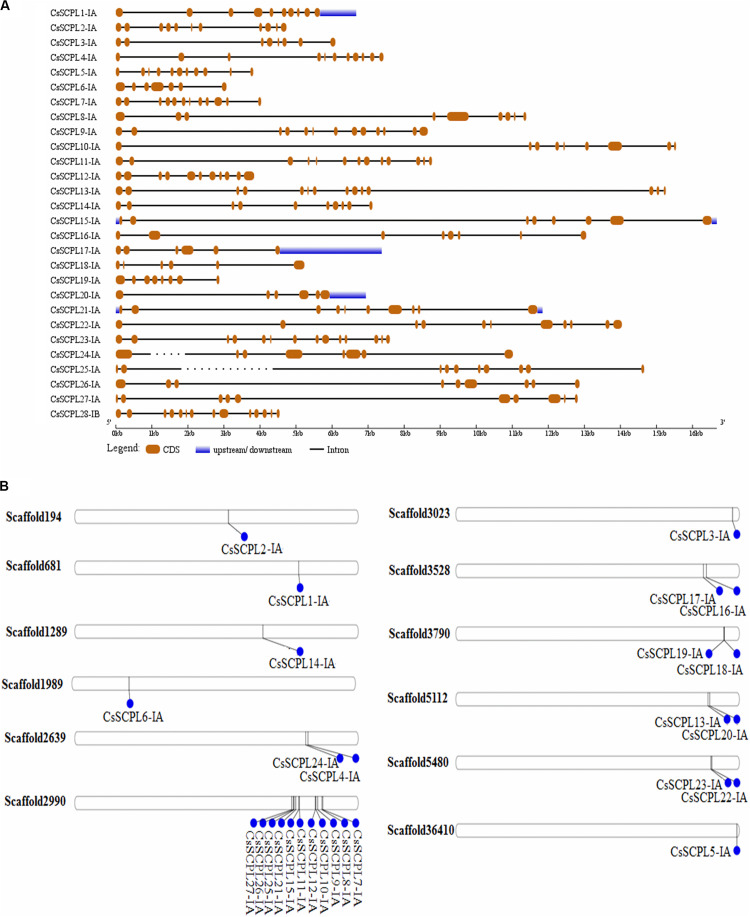
Gene architecture of tea CsSCPL genes. (A) The gene structures of CsSCPLI were plotted using red boxes representing exons, black lines representing introns, and blue boxes indicating UTR sequences. The scale in the bottom is in the unit of kilobase (kb). (B) Scaffold locations and duplications of CsSCPL-I genes. Scaffold numbers are indicated on leftside of each respective scaffold. The different genes located according to their presence in bps.